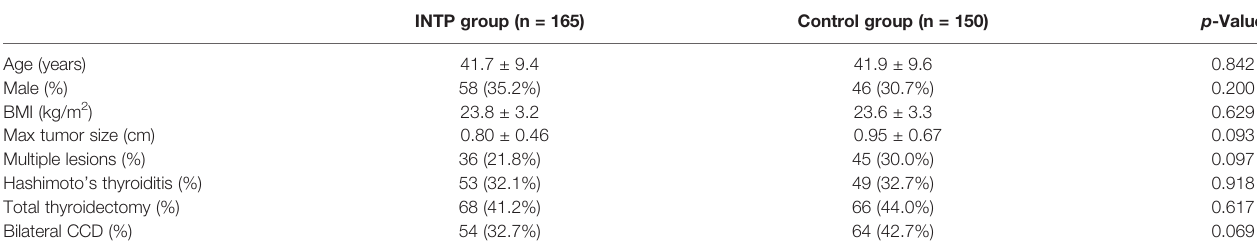
TABLE 1 | Clinicopathologic characteristics in open